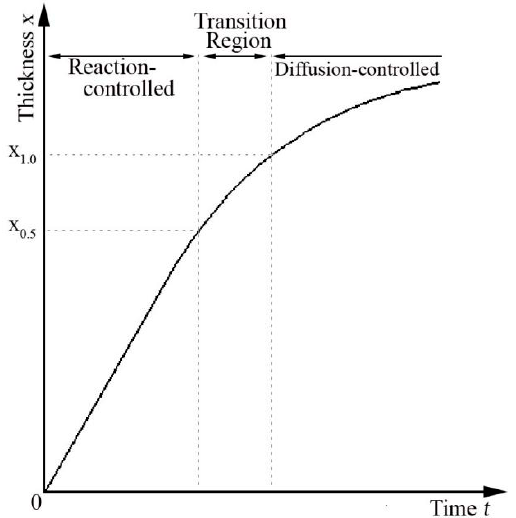
Figure 8. Schematic diagram of growth controlled mechanism.